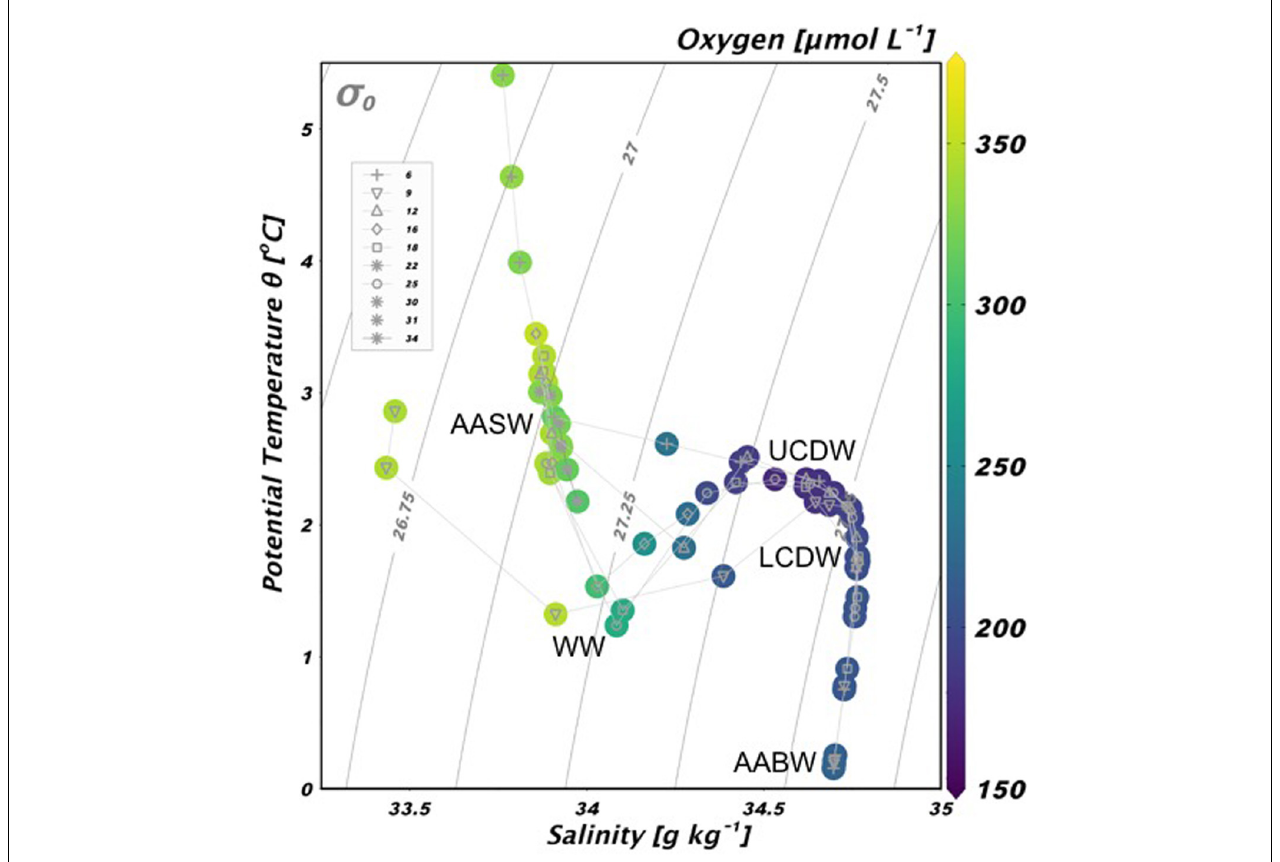
FIGURE 4 | Temperature-salinity diagram for the samples collected during the HEOBI